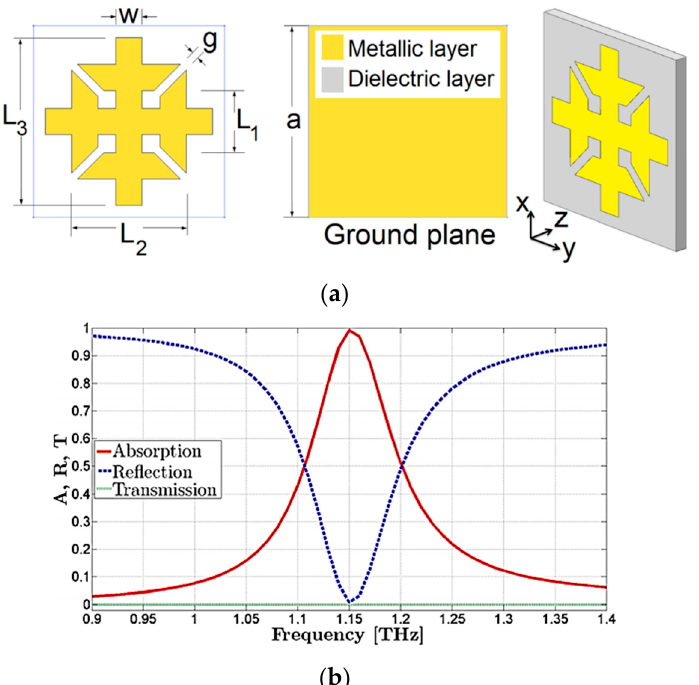
Figure 5. ( a ) Structure of polarization-insensitive ultra-thin narrowband absorber; ( b ) absorption, reflection, and transmission curves [42].